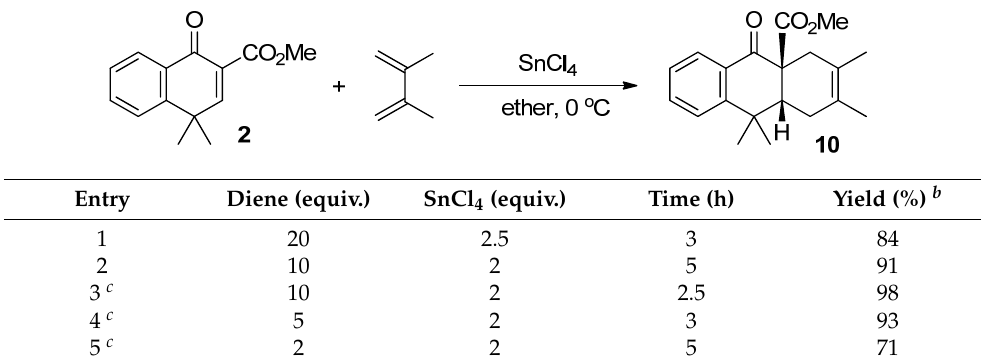
Table 1. Screening of Diels–Alder cycloaddition conditions a .